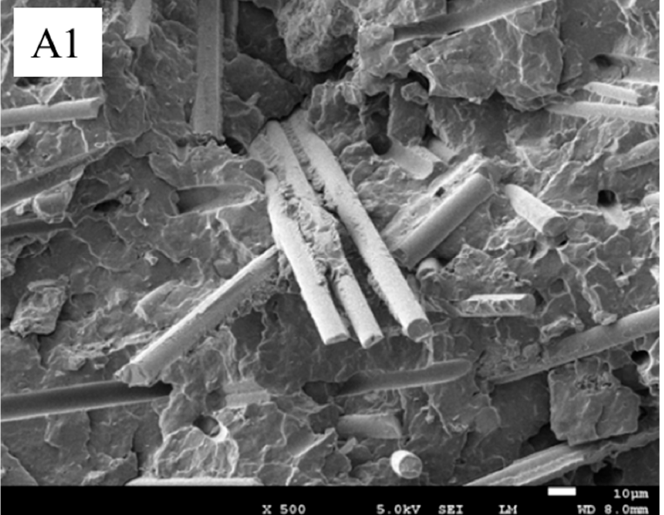
Figure 9. Effect of bed temperature on the average particle size of modified N-WPCBs and the mechanical properties of PP/N-WPCB